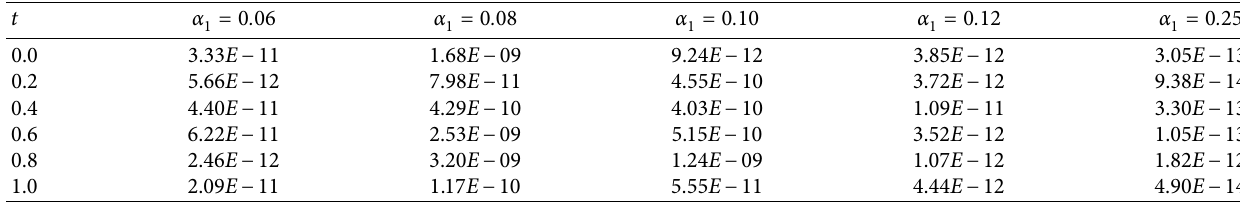
Table 7: Absolute errors obtained by the LeNN-WOA-NM algorithm for population density of immigrant prey X ( t ) under the influence of the intrinsic growth rate of local prey α 1